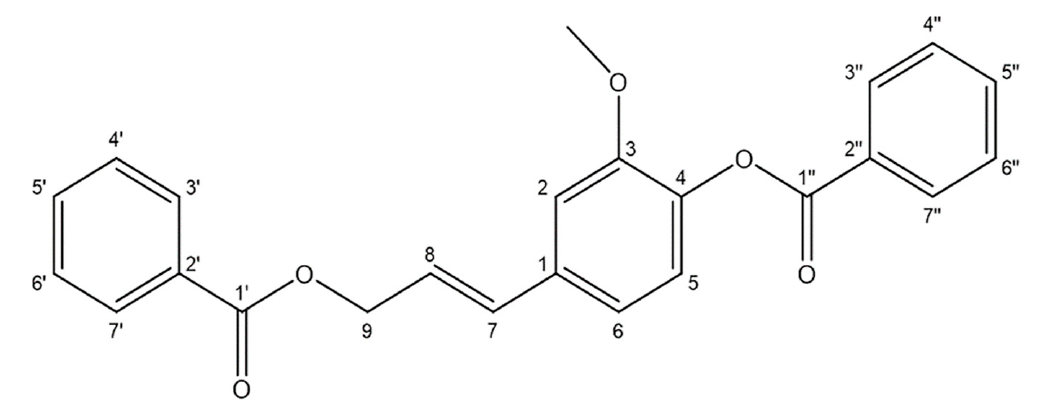
Figure 1. Structure of stybenpropol A.